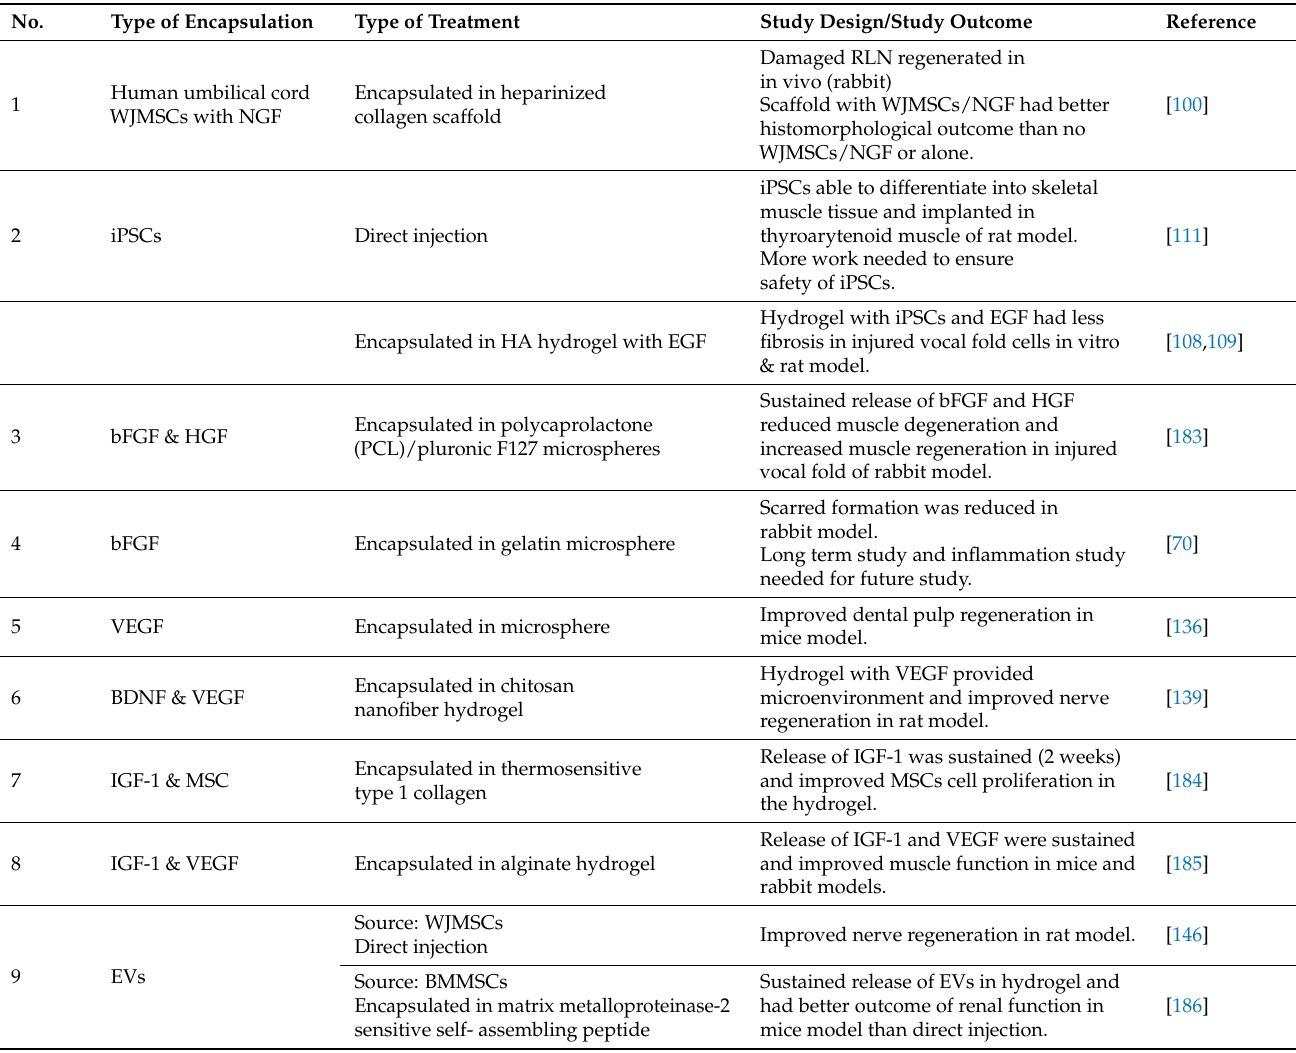
Table 2. Cells or biomolecules which had potential for hydrogel encapsulation for vocal fold injection (based on literature